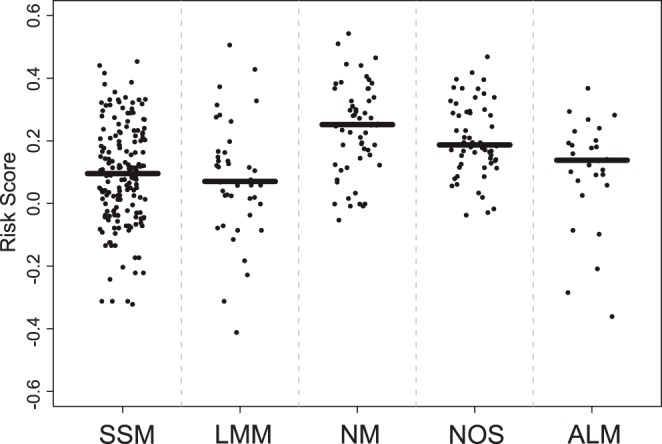
Dot blot of risk scores for the various histological subtypes of melanoma as classified by the ICD-10 (International Statistical Classification of Diseases and Related Health Problems, 10th revision).SSM, superficial spreading melanoma; LMM, lentigo maligna melanoma; NM, nodular melanoma; NOS, not otherwise specificed; ALM, acral lentiginous melanoma. Horizontal lines represent median risk scores for each subgroup.The aim of this study was to provide a maximum of prognostic and therapeutically relevant information by a minimum of markers combined in a clear signature. For the sake of clinical feasibility and cost saving, an IHC marker set suitable for routine clinical assessment should be based on a limited number of antibodies. Accordingly, the nine-marker signature was reduced by the risk marker with the lowest Cox regression coefficient β, i.e. MLH1 (β = 0.254).